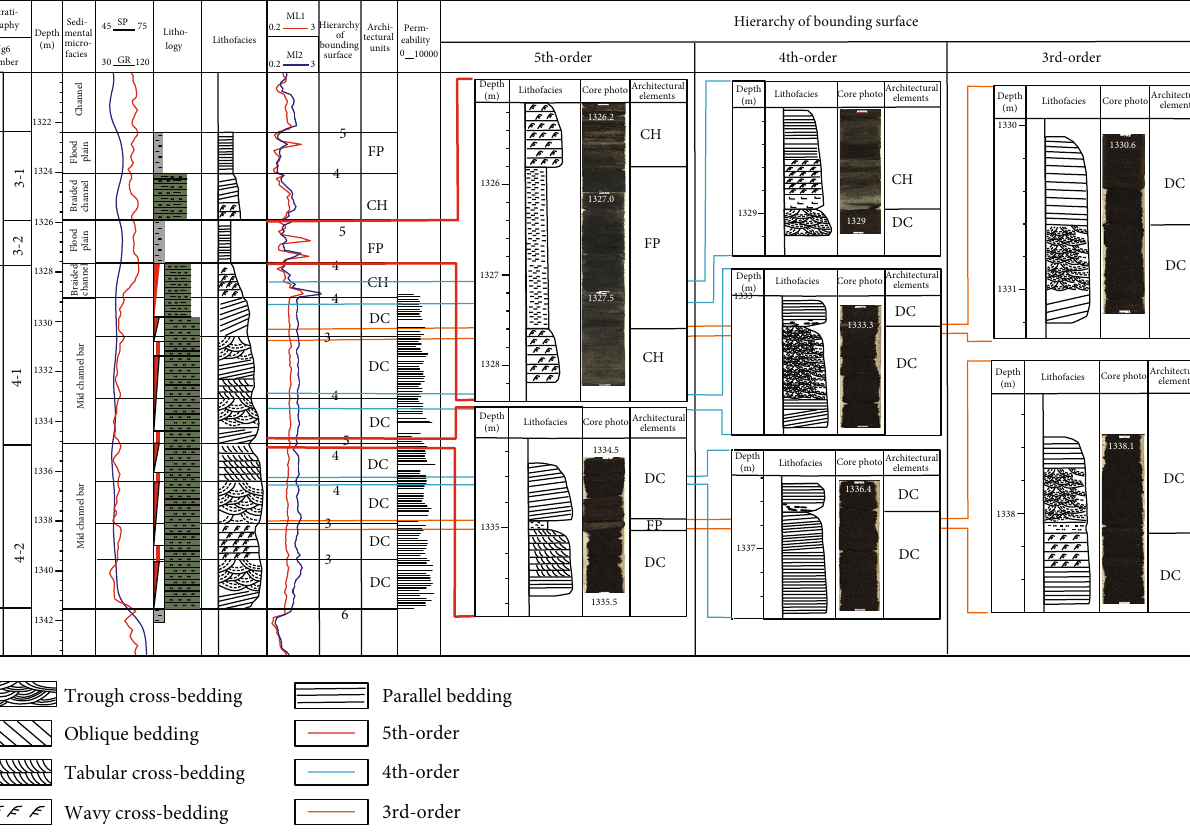
Figure 6: Lithological characteristics of hierarchical bounding surfaces. FP: fl ood plain; CH: channel; DC: channel